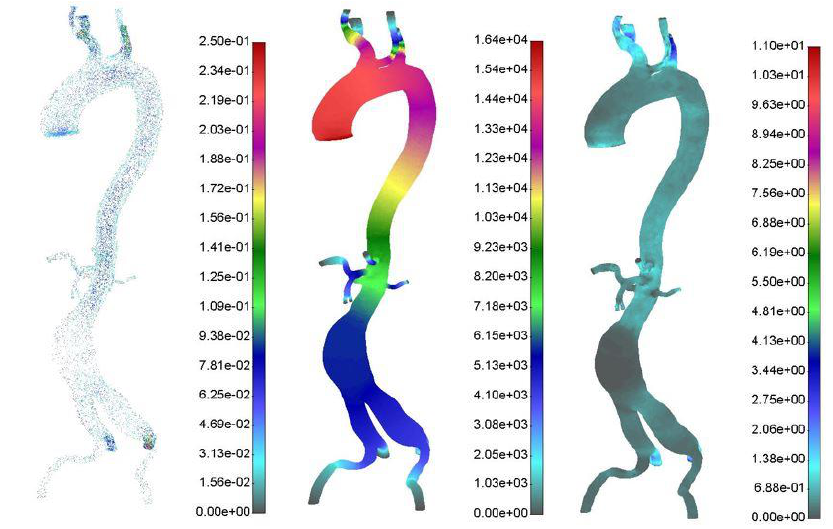
Figure 3. Case A: Velocity field (Units: m/s ), Pressure (Units: Pa ) and Shear stress (Units: Pa ) distribution,